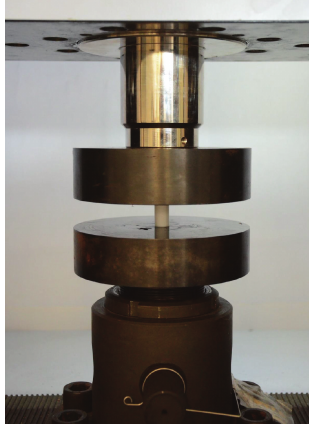
Figure 5: Test system equipped with a 25 kN load cell.